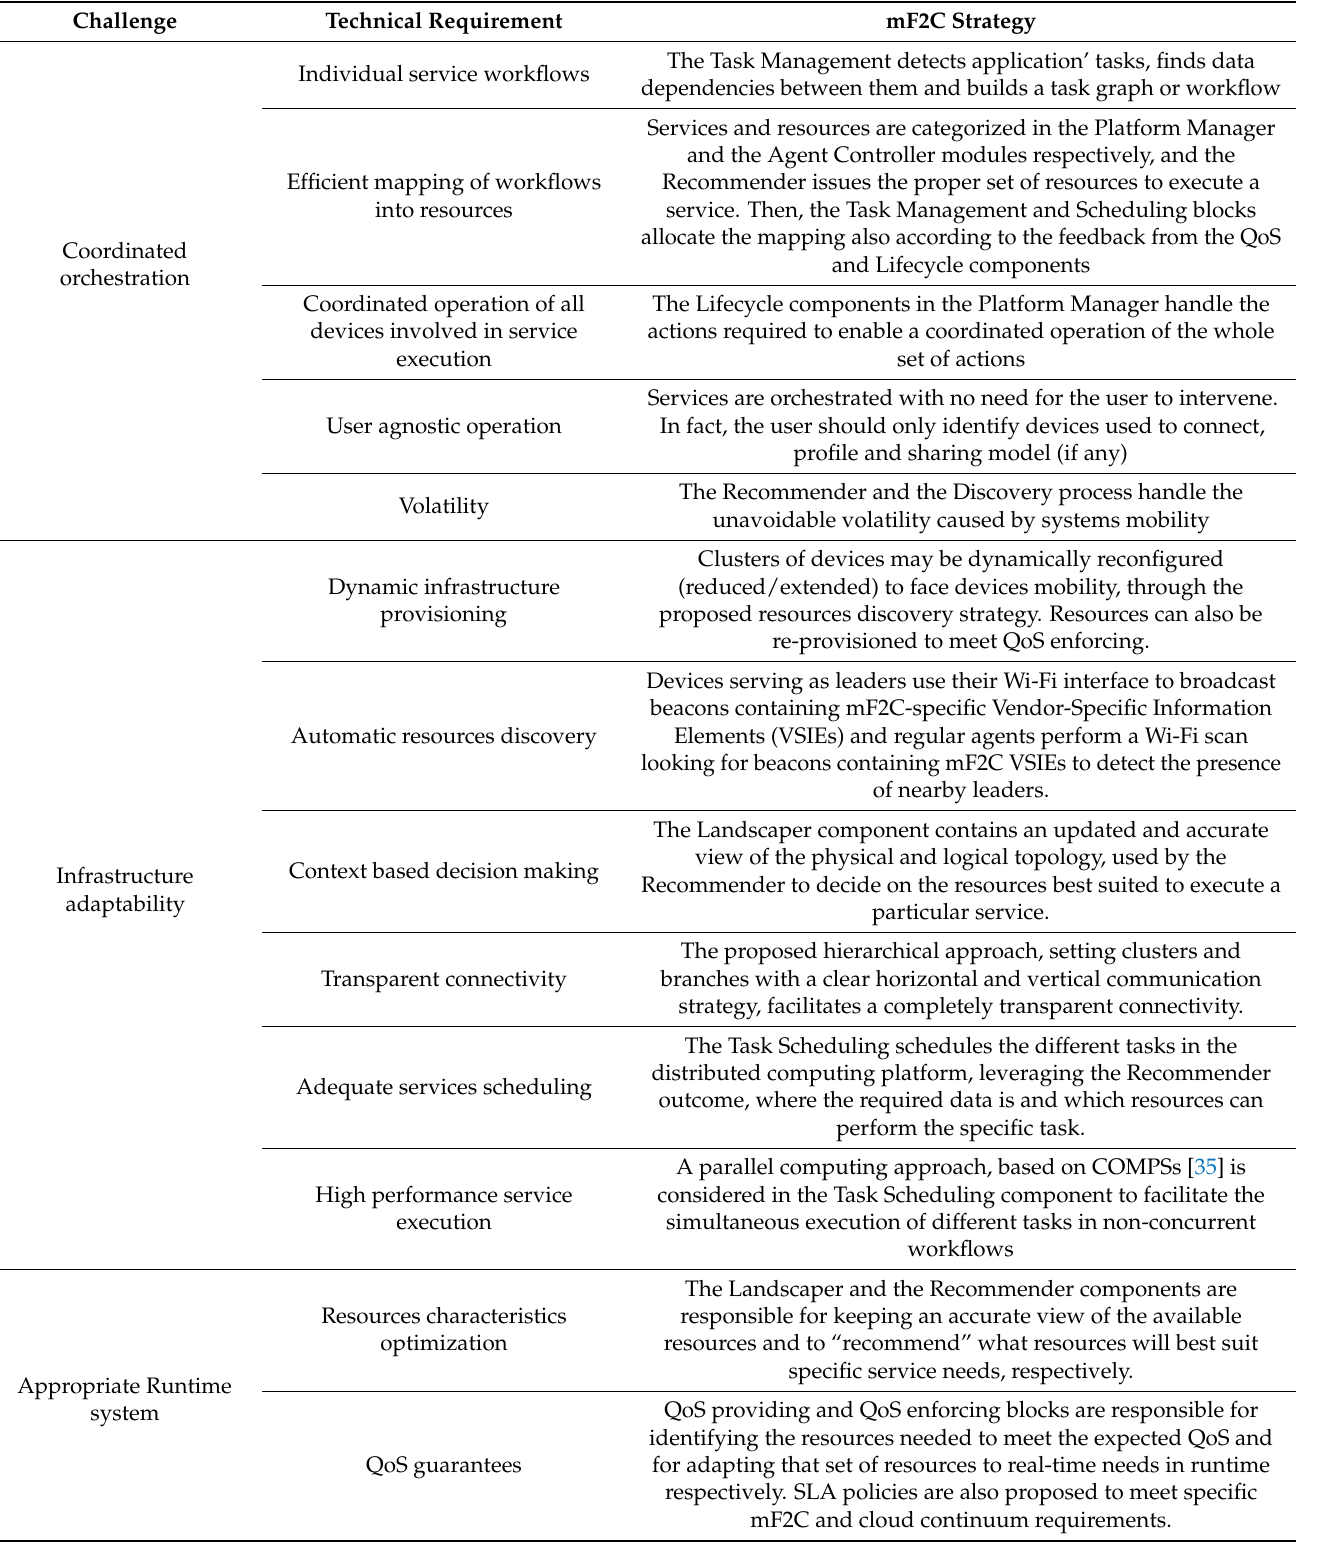
Table 1. mF2C strategy to face defined challenges and